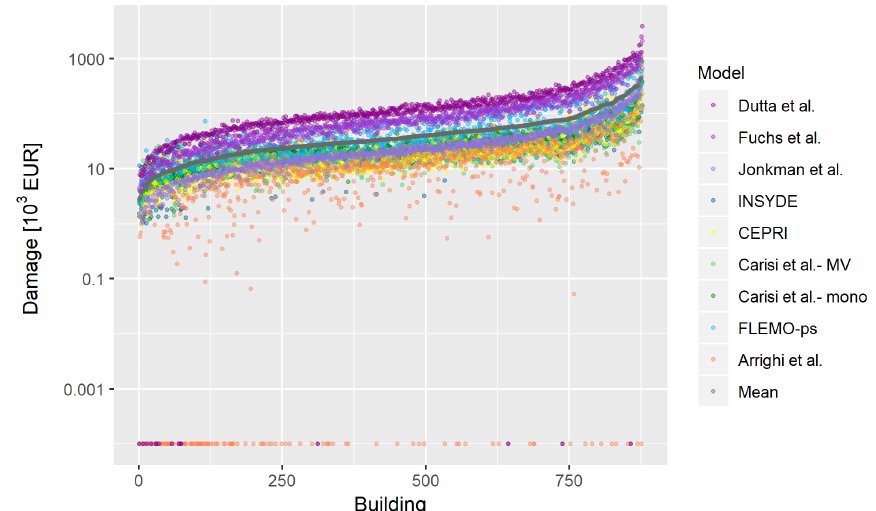
Figure 3. Individual estimates of the monetary damage for all the buildings in the flooded area. Data are ordered according to increasing value of mean estimate (in grey). Zero damages are due to the modelling assumptions behind the specific damage models (i.e. 0.25m water depth threshold for damage occurrence in Arrighi et al. and 0.01m water depth threshold in Dutta et al. and Jonkman et al. to distinguish between flooding and surface water